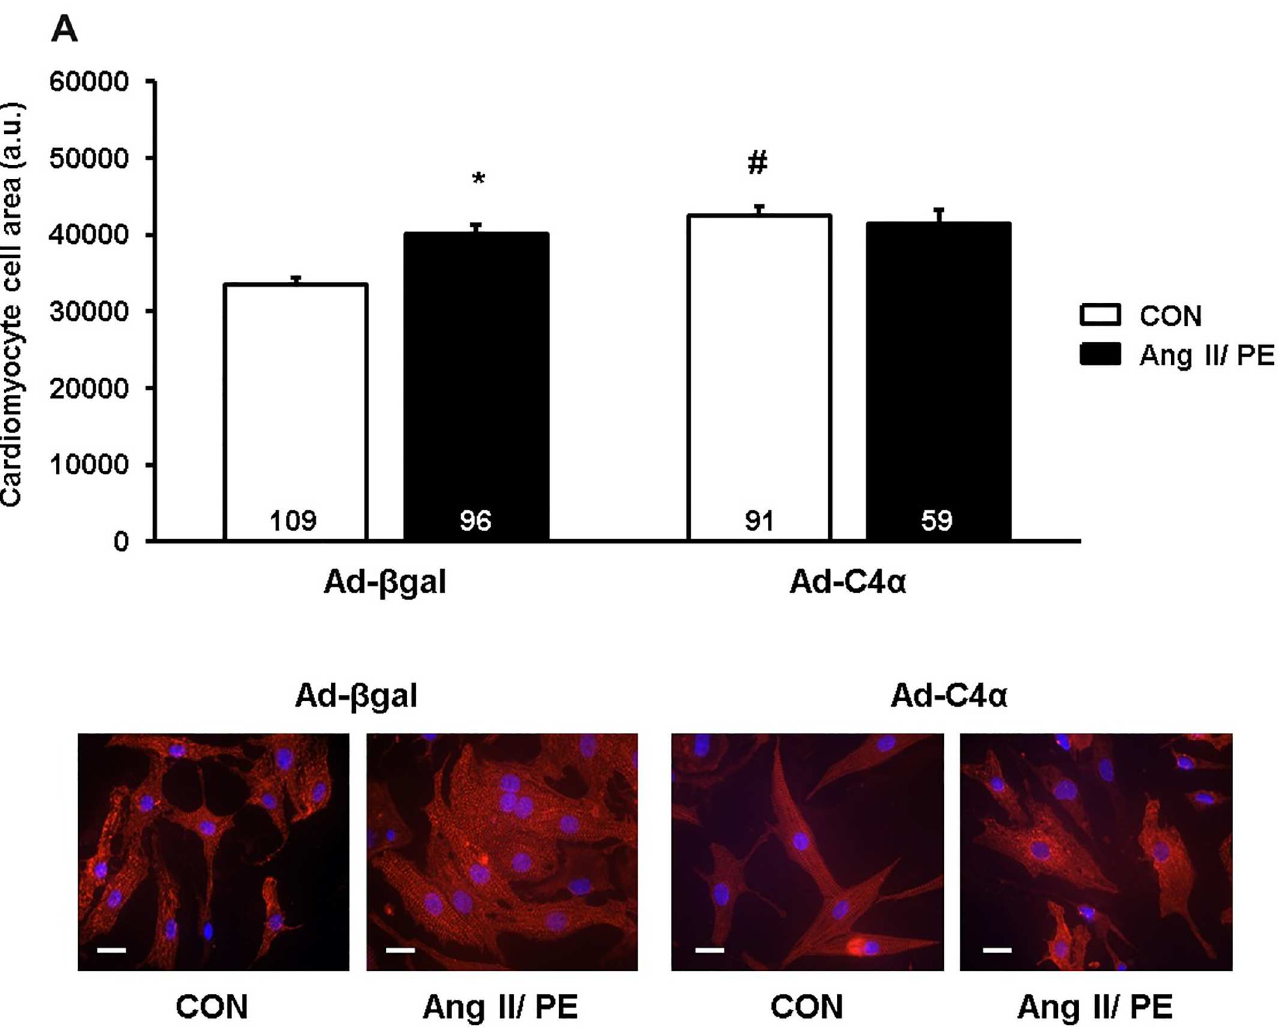
Fig 6. TRPC4 α increasescardiomyocyte hypertrophy at baseline but not after GPCR stimulation. A, B Hypertrophic growth of cardiomyocytes was measured as an increaseof the cell surface after angiotensin II/phenylephrine (Ang II/PE) or vehicle(CON) treatment for 24 h. Red: α -actinin; Blue: DAPI. * P < 0.05vs Ad- β galCON; # P < 0.05vs Ad- β galCON. Cells from at least three different experiments were analyzed.Scale bar: 20 μ m. N- number of cells is indicatedin the